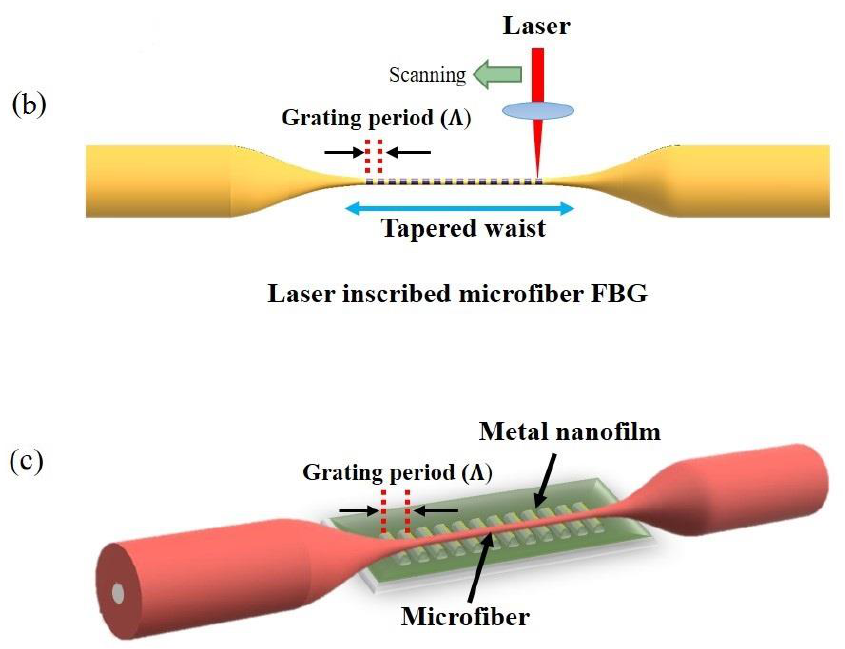
Figure 14. ( a ) Schematic of the FIB inscribed grating at the MF tapered tip for temperature sensor; ( b ) The schematic of laser inscribed Bragg grating in MF; ( c ) The schematic of a MF placed on top of metal nanofilm Bragg grating.